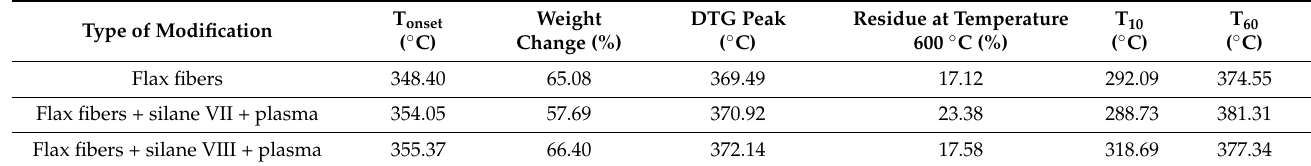
Figure 1. TGA results for unmodified and modified fibers. Table 1. Values of TGA for long flax before and after modification.